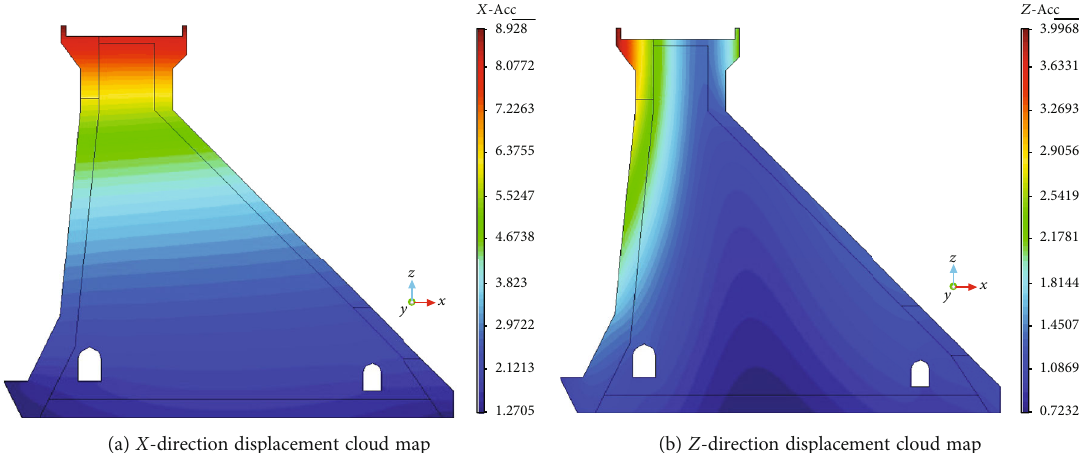
Figure 9: Typical section of concrete gravity dam retaining dam body along river acceleration cloud fi gure (m/s 2